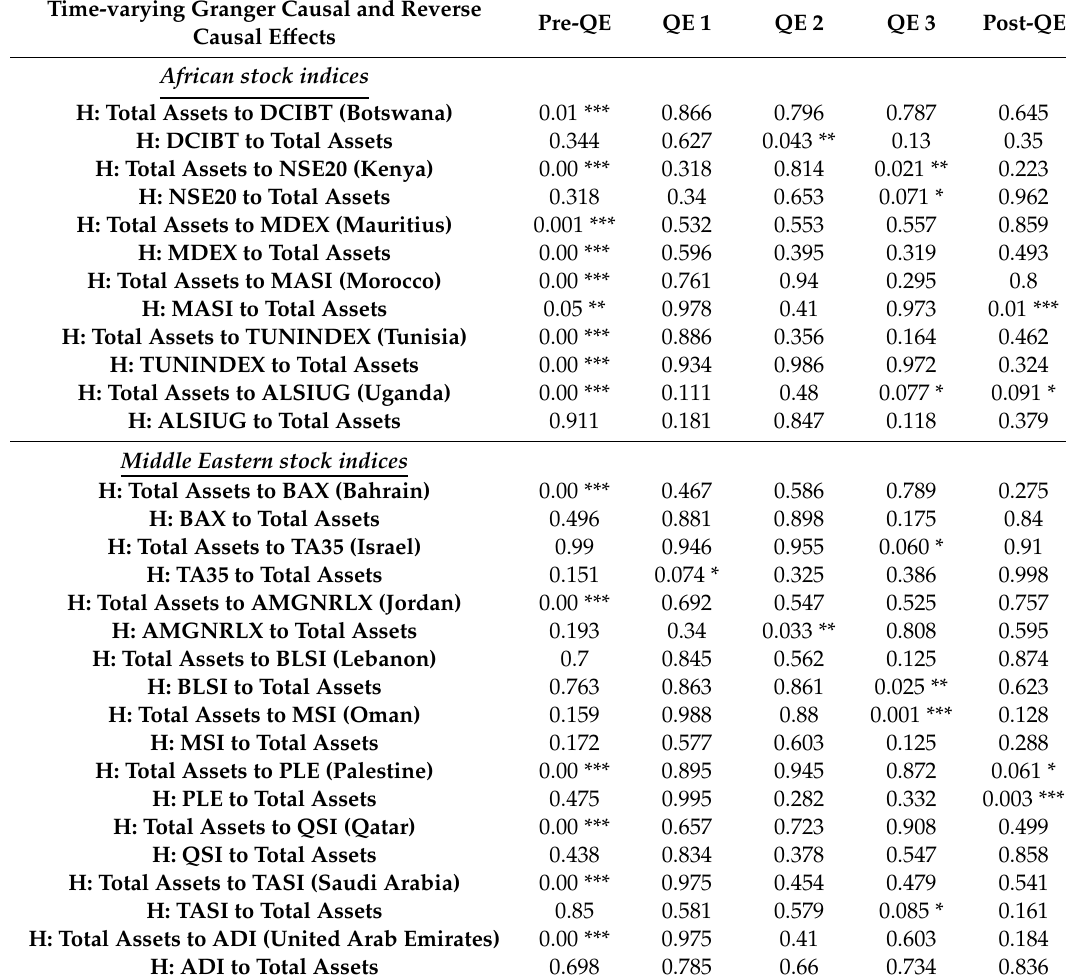
Table 8. Results of the time-varying Granger causality